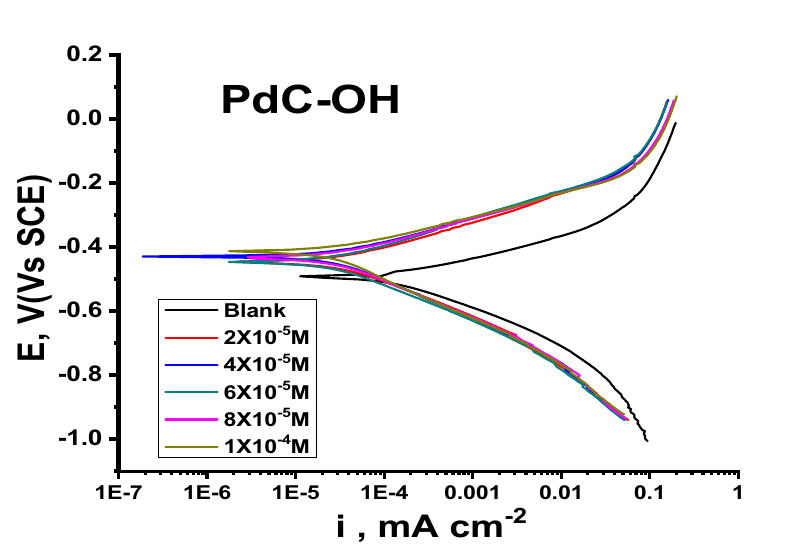
Figure 7. Potentiodynamic polarization plot for the corrosion of carbon steel in 1 M HCl without and with different concentrations of PdC-OH at 25